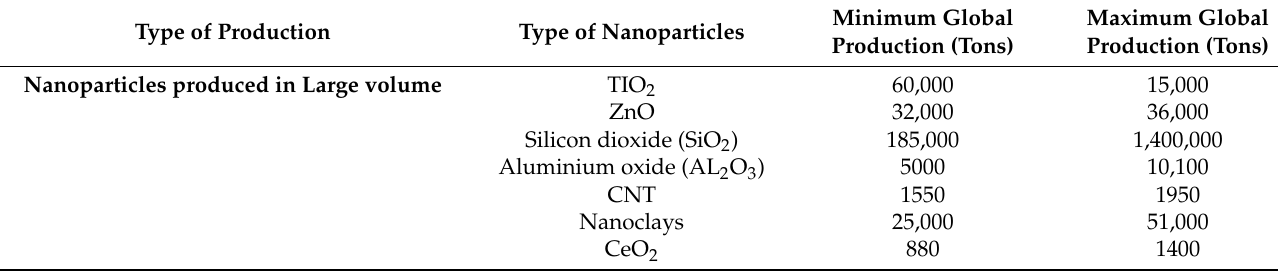
Table 2. Global production of nanoparticles